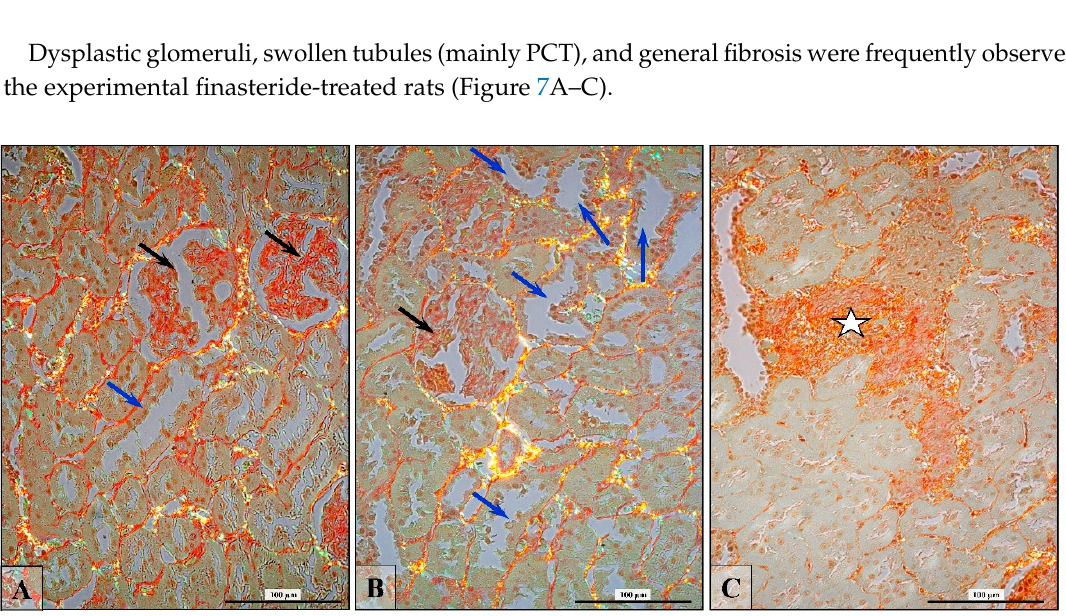
Figure 7. The representative microphotographs showing pathologically changed kidney of finasteride-treated rats ( A – C ): dysplastic glomeruli (black arrows), overloaded tubules (blue arrows), general interstitial fibrosis (asterisk). Sirius Red Staining, polarized microscopy. Scale bar: 100 µm.